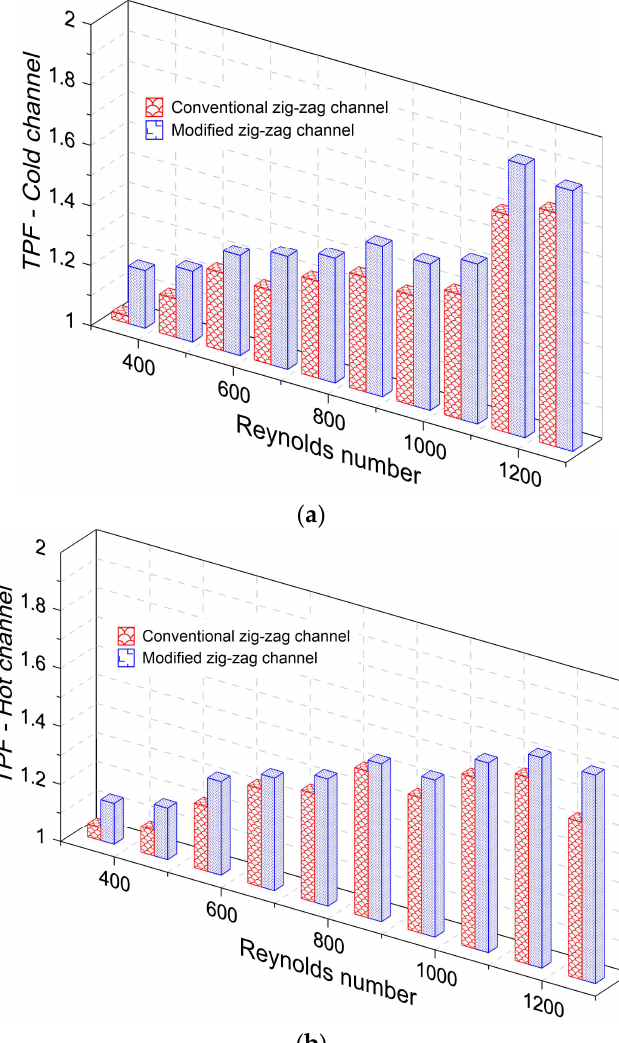
Figure 10. Thermal performance factor for the different channel configurations: ( a ) cold channel; ( b ) hot channel.